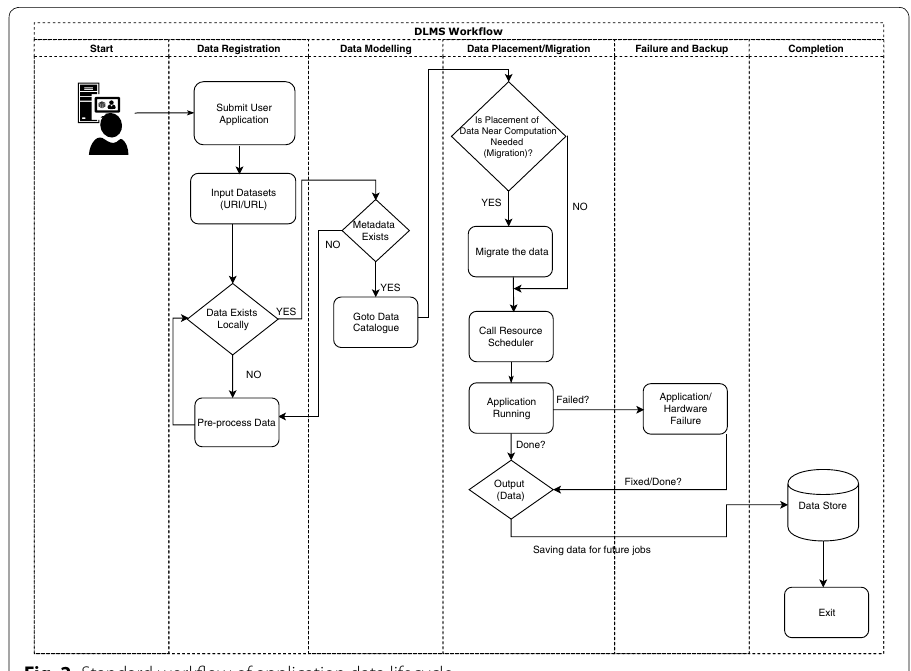
Fig. 2 Standard workflow of application data